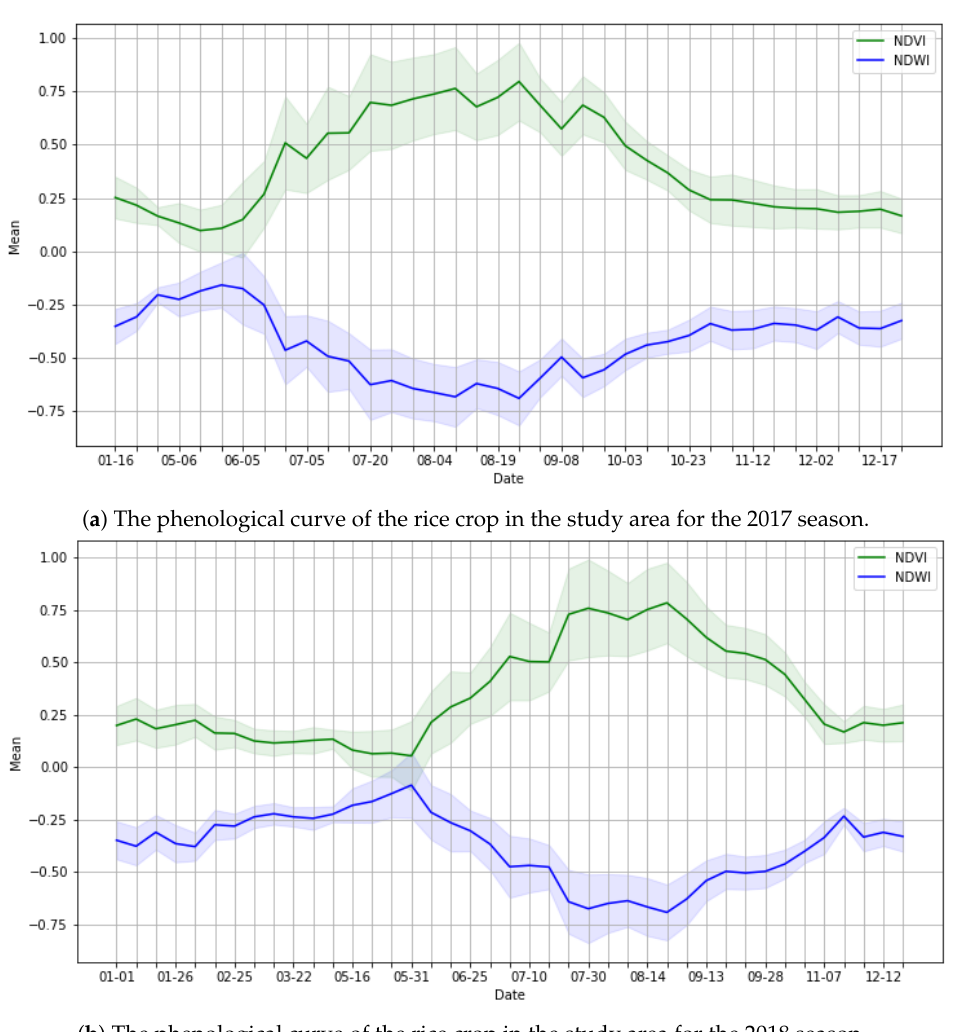
Figure 4. Phenological curves based on the mean and twice the standard deviation, for the 2017 and 2018 seasons in the study area.